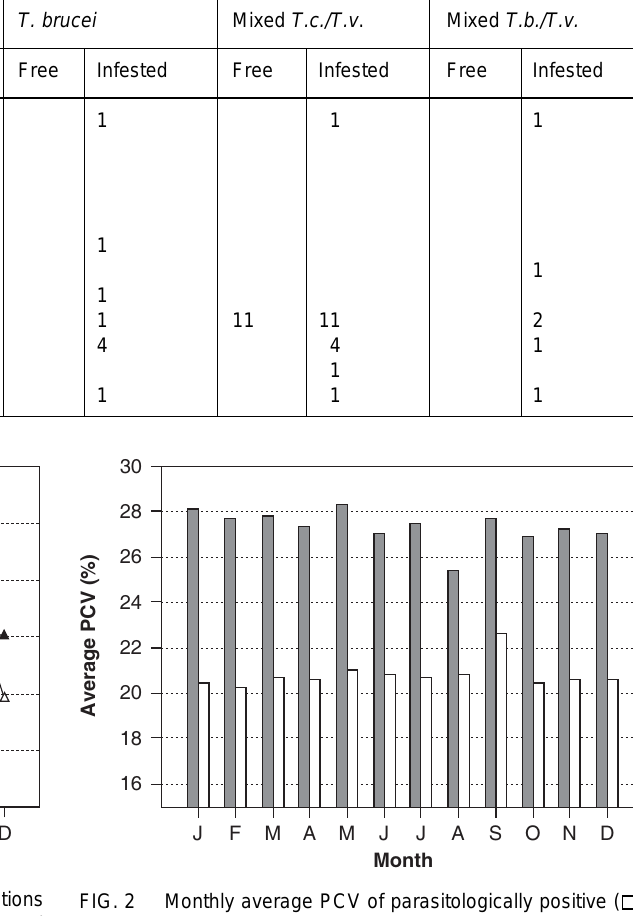
FIG. 2 Monthly average PCV of parasitologically positive ( ) and negative ( ) cattle